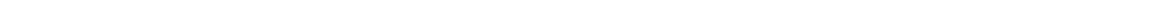
Fig. 4 Bumetanide restores GABAergic inhibition in CGINs. a Cell-attached recordings of current through single GABA A channels with GABA (1 μ M) in patch pipette in CGIN at different holding potentials. b I – V relationships of the currents through single GABA A channels in CGINs in control and 6-OHDA- treated striatum; their reversal potential corresponds to DF GABA . c Summary plot of DF GABA of CGINs inferred from single GABA A channels recordings. d Cell-attached recordings of single NMDA channel current with NMDA (10 μ M) in patch pipette in CGINs at different holding potentials e I – V relationships of the currents through NMDA channels in CGINs in control and 6-OHDA-treated striatum; their reversal potentials correspond to resting membrane potentials ( V R ). f Summary plot of V R of CGINs inferred from the reversal of single NMDA channels recorded in cell-attached mode. g Isoguvacine (10 μ M) inhibited CGINs spontaneous activity (cell-attached recordings) in control, h but not in 6-OHDA-treated mice. i Bumetanide treatment restored inhibition in 6-OHDA-treated mice. j Effects of isoguvacine on spike frequency (normalized to control). k Pooled instantaneous frequency distributions of CGIN spontaneous spikes in control and 6-OHDA-treated mice with or without bumetanide treatment. l Corresponding mean frequencies of CGINs spiking activity. All means ± SEM. c , f Signi fi cance was determined by two-tailed, unpaired Student ’ s t -test; see Supplementary Tables 10,11 for statistics. j , l Data sets were analyzed using one-way ANOVA followed by Fisher ’ s least signi fi cant difference (LSD) post-hoc test; see Supplementary Tables 12,14